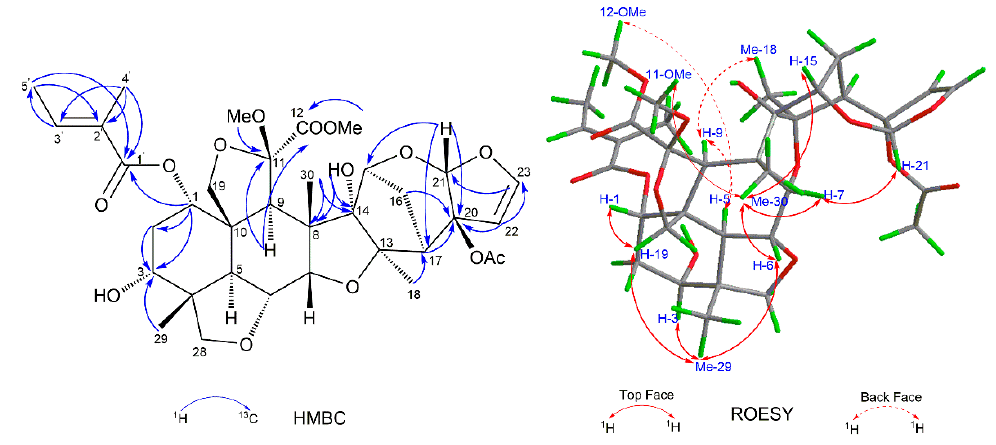
Figure 2. Key HMBC and ROESY correlations of compound 1 .